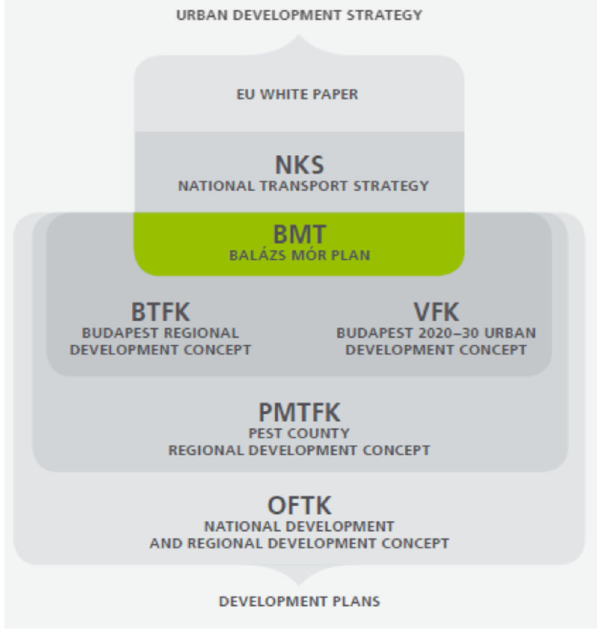
Fig. 8 Connections of BMT to other strategic development plans [2] pp.